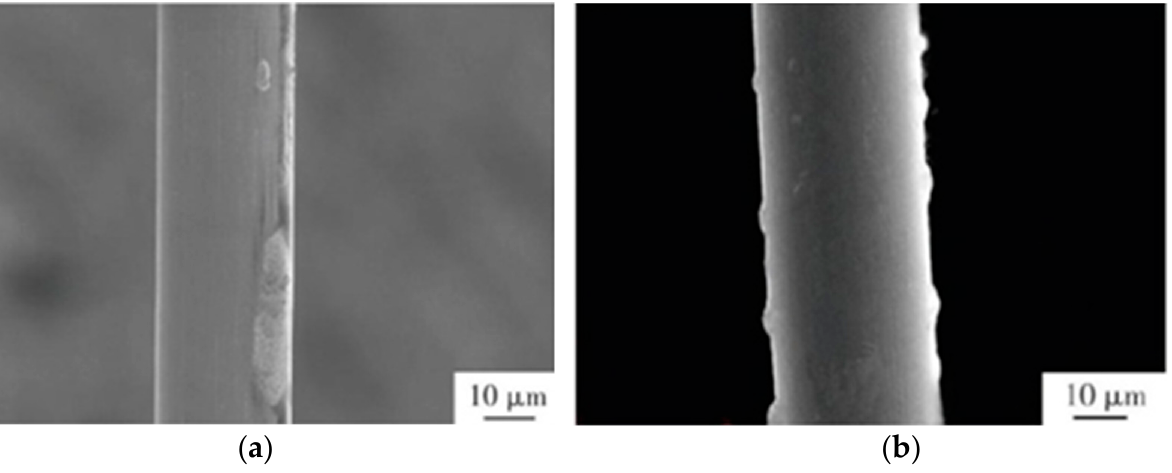
Figure 6. Surface morphology of Pd-coated Cu wire: ( a ) the coating flakes off; ( b ) the coating bumps [100]. Reproduced with permission from Ref. [100]; published by Heat Treatment of Metals, 2016.